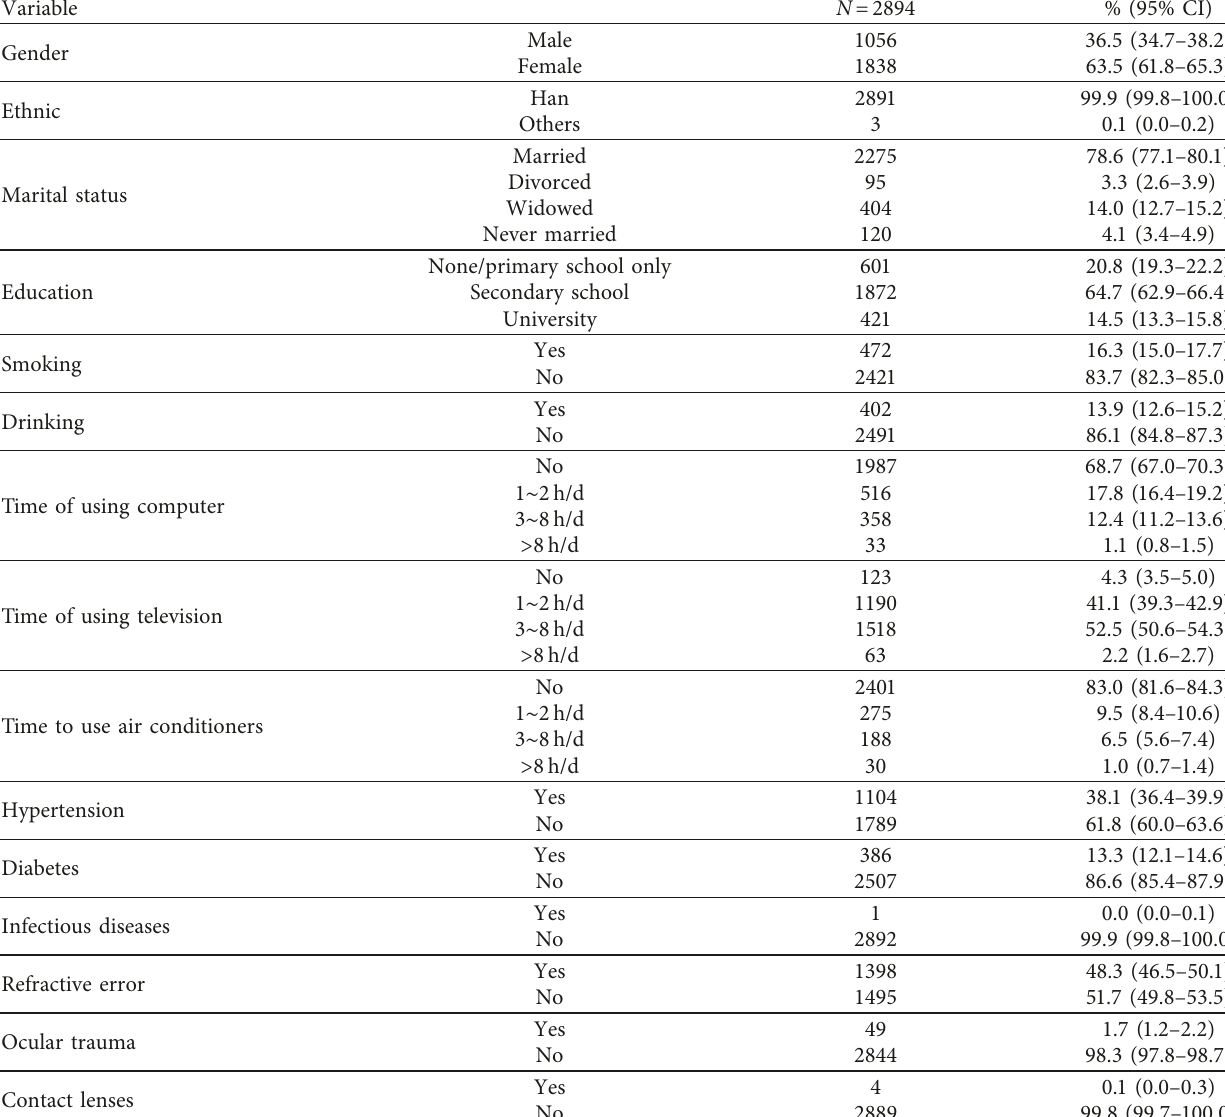
Table 1: Baseline characteristics of participants ( N �